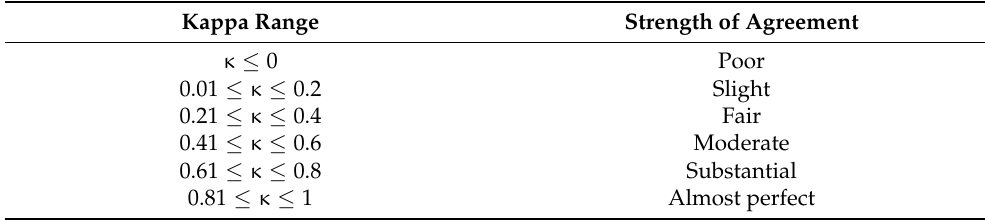
Table 5. Strength of agreement using the kappa